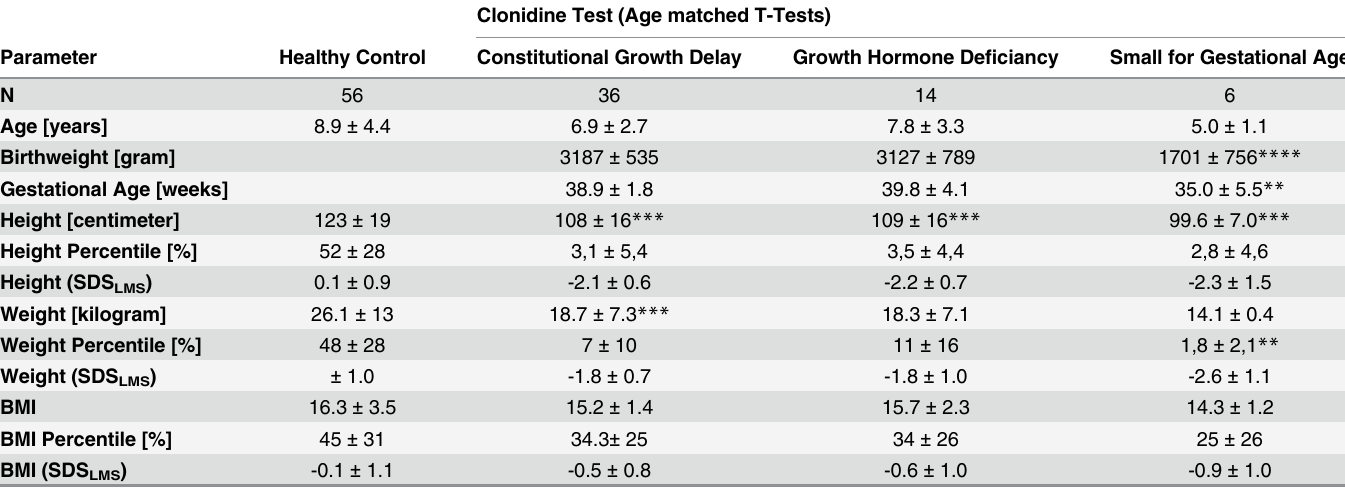
Table 1. Anthropomethrical data of healthy controls and children with CGD, GHD and SGA. Clonidine Test (Age matched